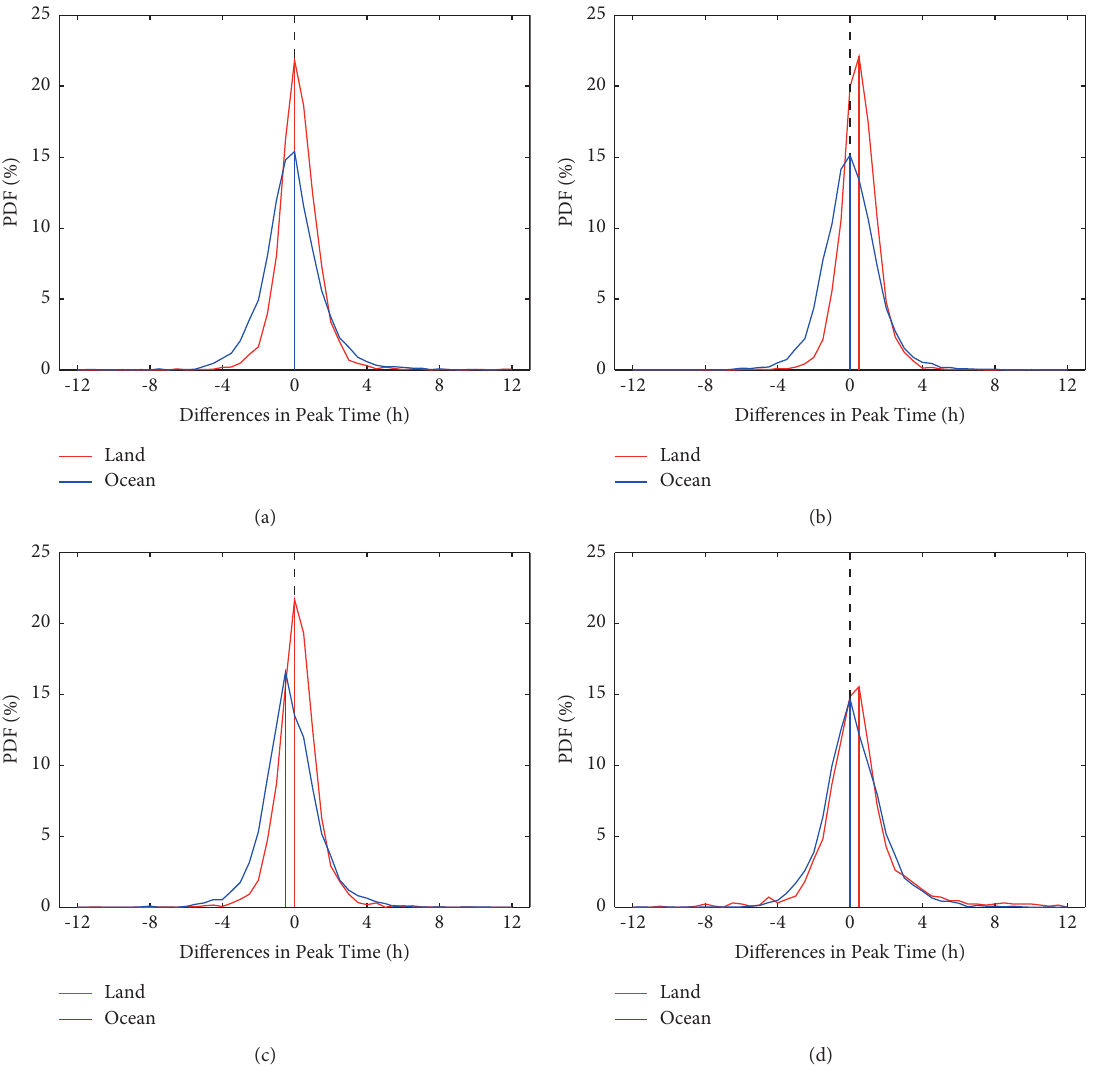
Figure 9: Probably density functions for the differences between the maximum times of the diurnal harmonics in the IMERG V06B product and TMPA 3B42 product in (a) spring; (b) summer; (c) autumn; and (d)